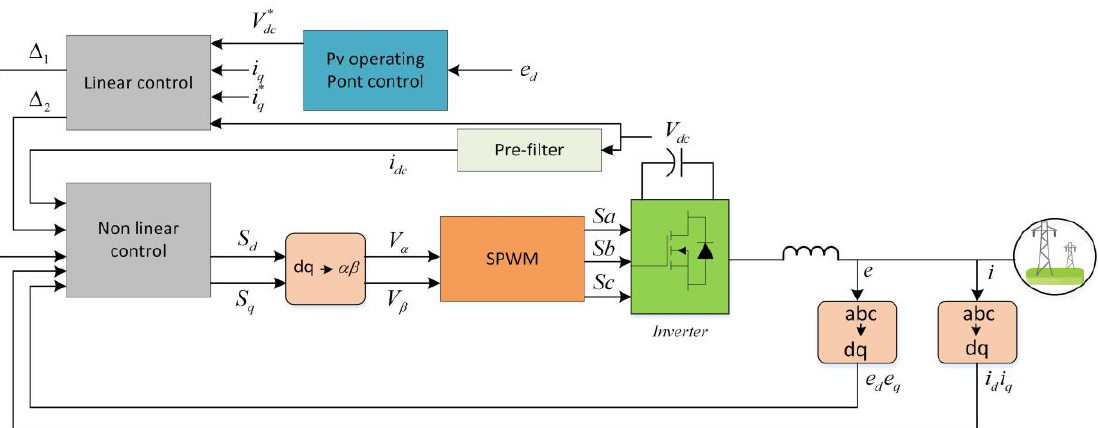
Figure 7. Control strategy scheme [46].